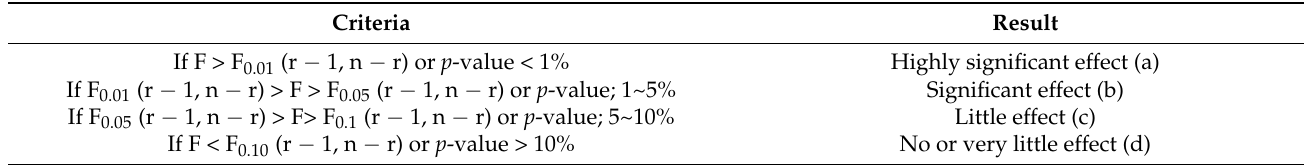
Table 5. Significant analyses based on one-way